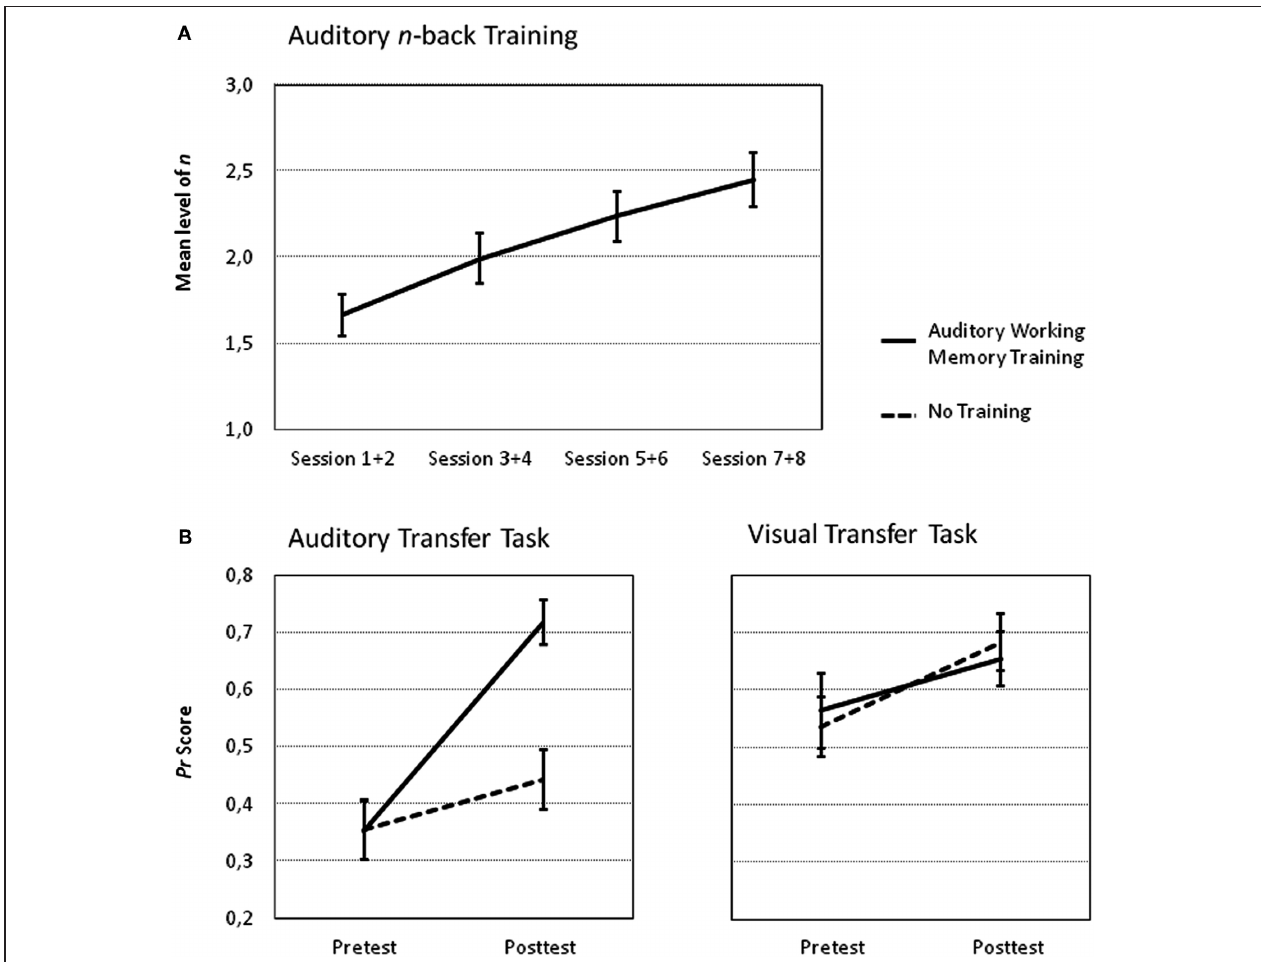
FIGURE 4 | Performance increase in the n-back task for the auditory training group. (A) The mean level of n as an indicator of the participants’ performance for each session and corresponding standard errors of the mean